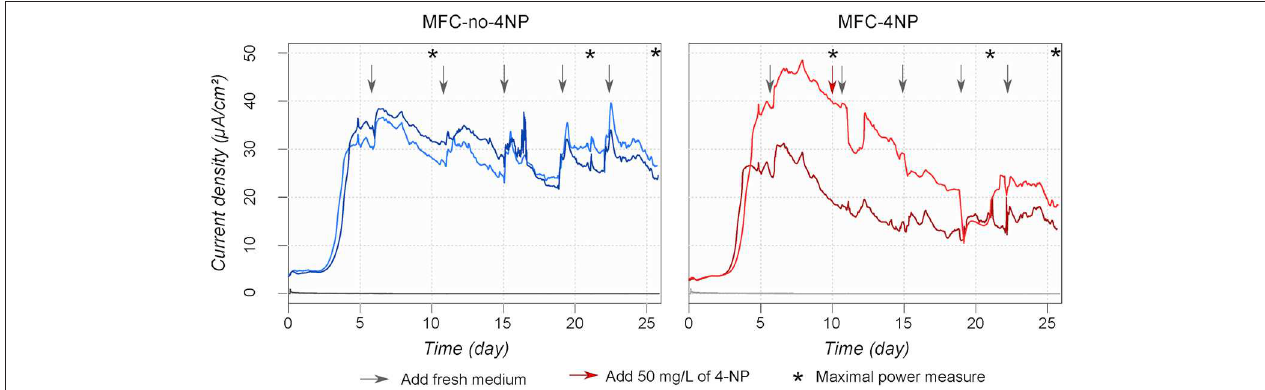
FIGURE 7 | Current density produced by MFCs amended or not in 4-NP. After 10 days 50 mg/L of 4-NP was added only to MFC-4NP (red arrow). The arrows represent the addition of fresh synthetic wastewater amended (red) or not (black) with 50 mg/L of 4-NP. The asterisks show when maximal power density measurements were made.